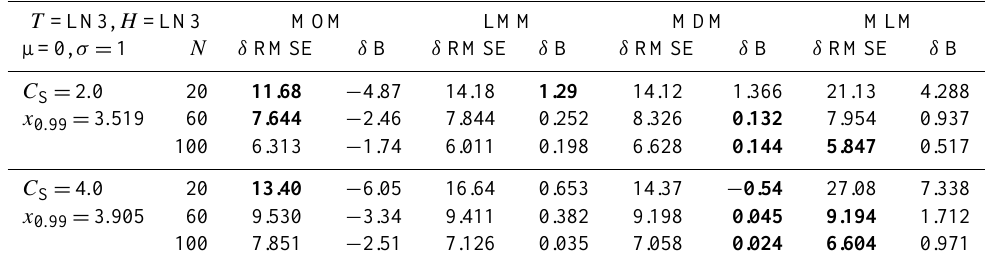
Table 5. Relative accuracy [ % ] of ˆ x 0 . 99 for a sample from LN3, assuming LN3 model. T =LN3, H =LN3 MOM LMM MDM